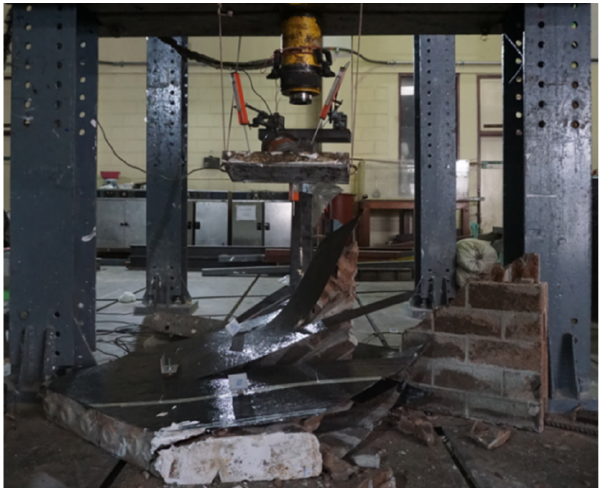
Figure 12. Cracking of control wall at load 247 kN.